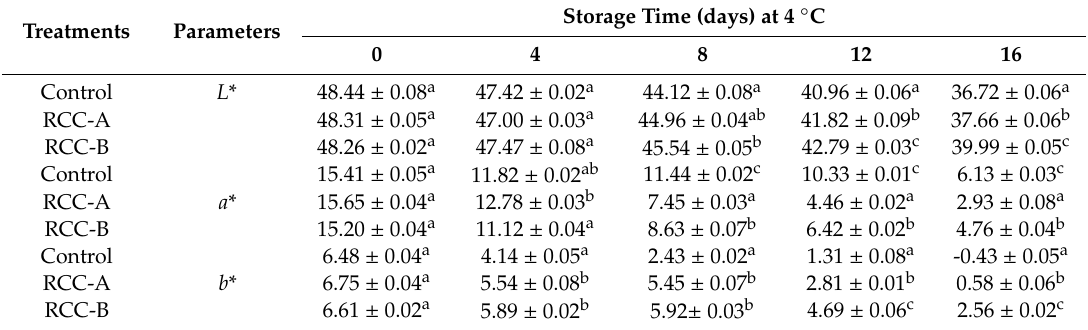
Table 6. Changes in color parameters of beef meat treated with RC extract during storage at 4 ◦